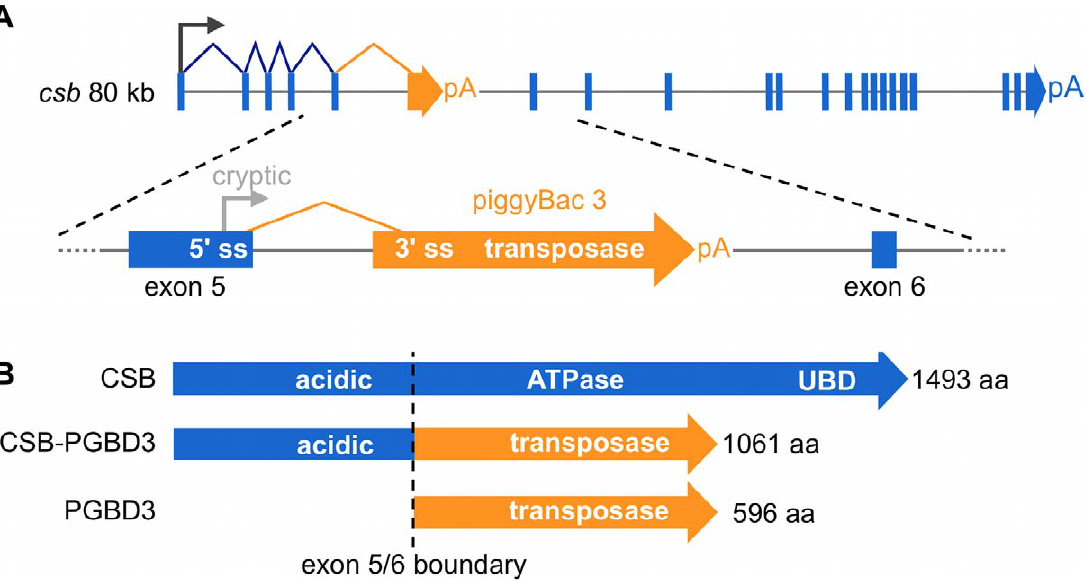
Figure 1. The CSB-PGBD3 fusion protein is abundantly expressed by alternative splicing and polyadenylation of the CSB transcript. (A) The CSB-PGBD3 fusion protein is expressed by alternative splicing of CSB exons 1–5 to the PGBD3 transposase 3 9 splice acceptor site, whereas solitary PGBD3 transposase is expressed from a cryptic promoter in CSB exon 5. (B) As a result, the primate CSB locus generates three proteins: full- length CSB, the CSB-PGBD3 fusion protein, and solitary PGBD3 transposase. pA, polyadenylation signal; 5 9 ss, 5 9 splice donor site; 3 9 ss, 3 9 splice acceptor site.